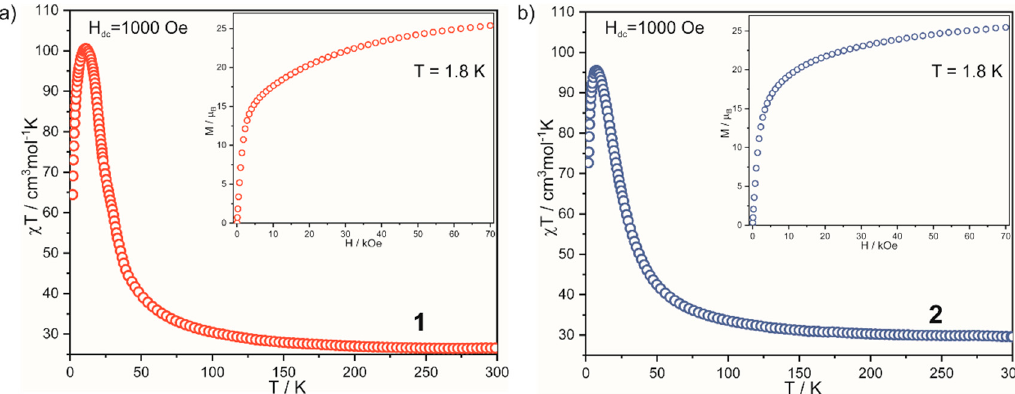
Figure 2. Temperature dependence of χ T for 1 ( a ) and 2 ( b ) measured at H = 1000 Oe. Inset: isothermal magnetization at T = 1.8 K for both compounds, 1 ( a ) and 2 ( b ).